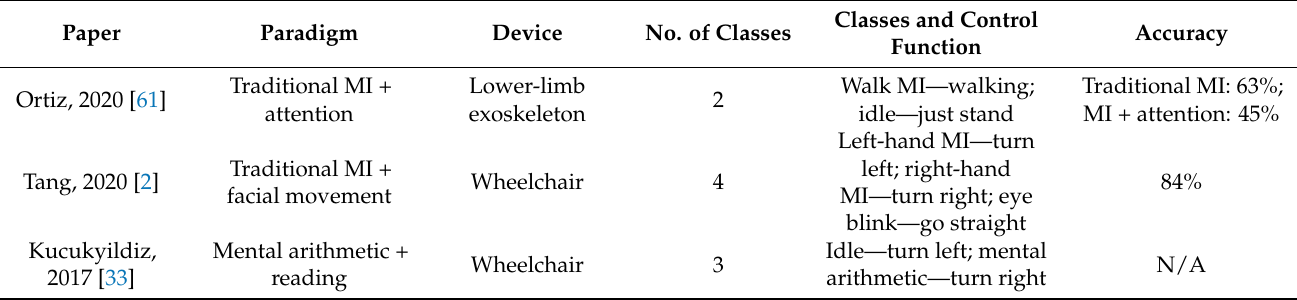
Table 2. A summary of EEG paradigms, devices, and control functions in the literature for multi- paradigm